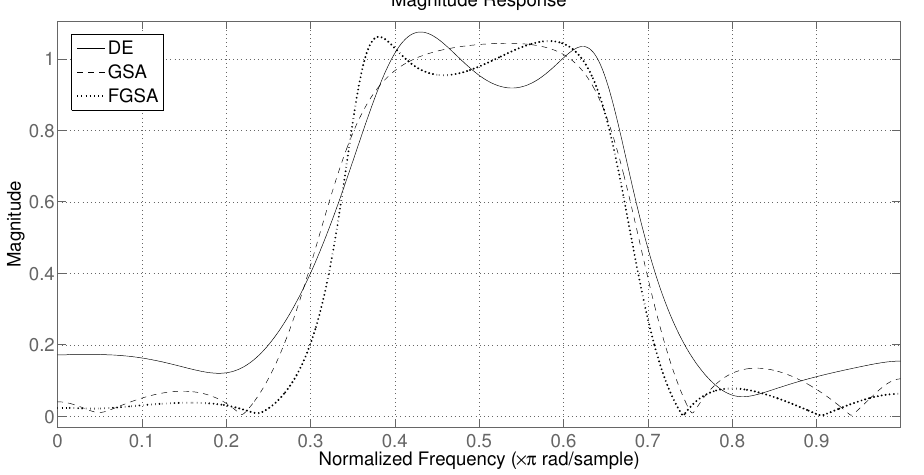
Figure 9. Magnitude response over normalized frequency for 8th order IIR Band Pass filter using DE, GSA and